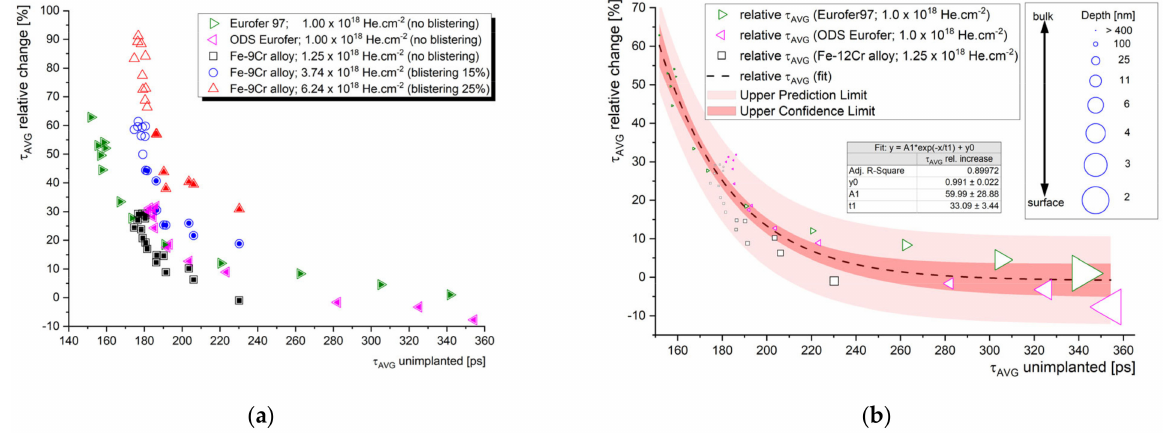
Figure 10. Relative change in the average positron lifetime in different irradiation experiments plotted as a function of the corresponding lifetime of the unirradiated sample ( a ). Exponential decay fit of datapoints obtained for three